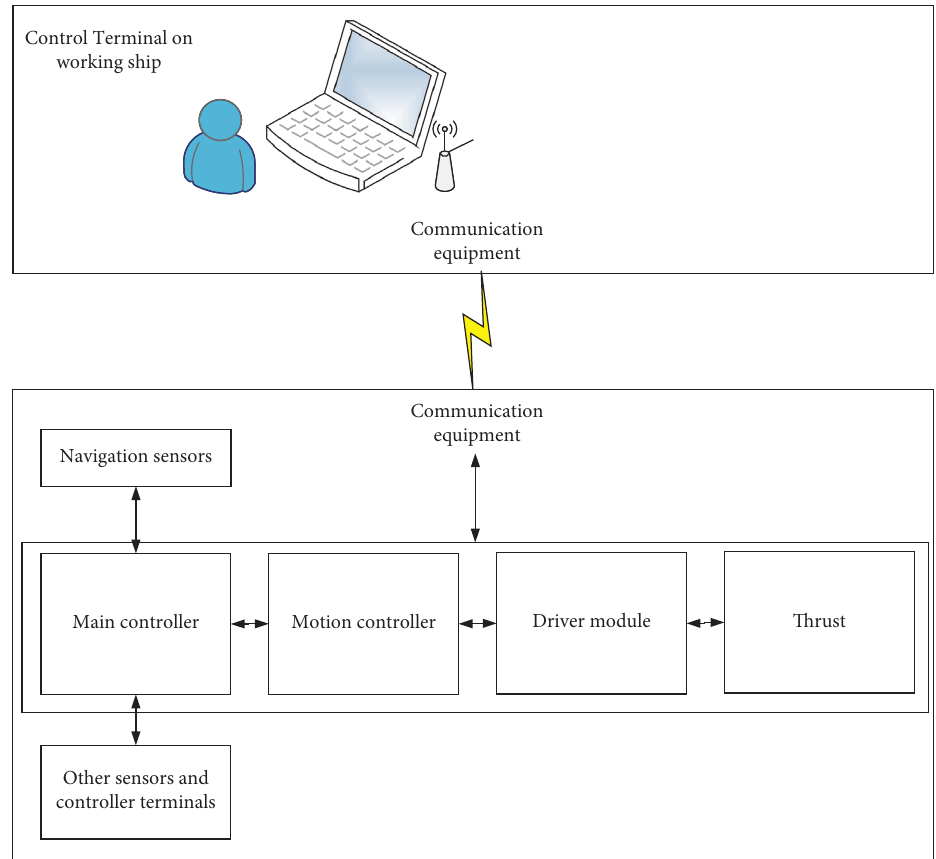
Figure 1: The control system